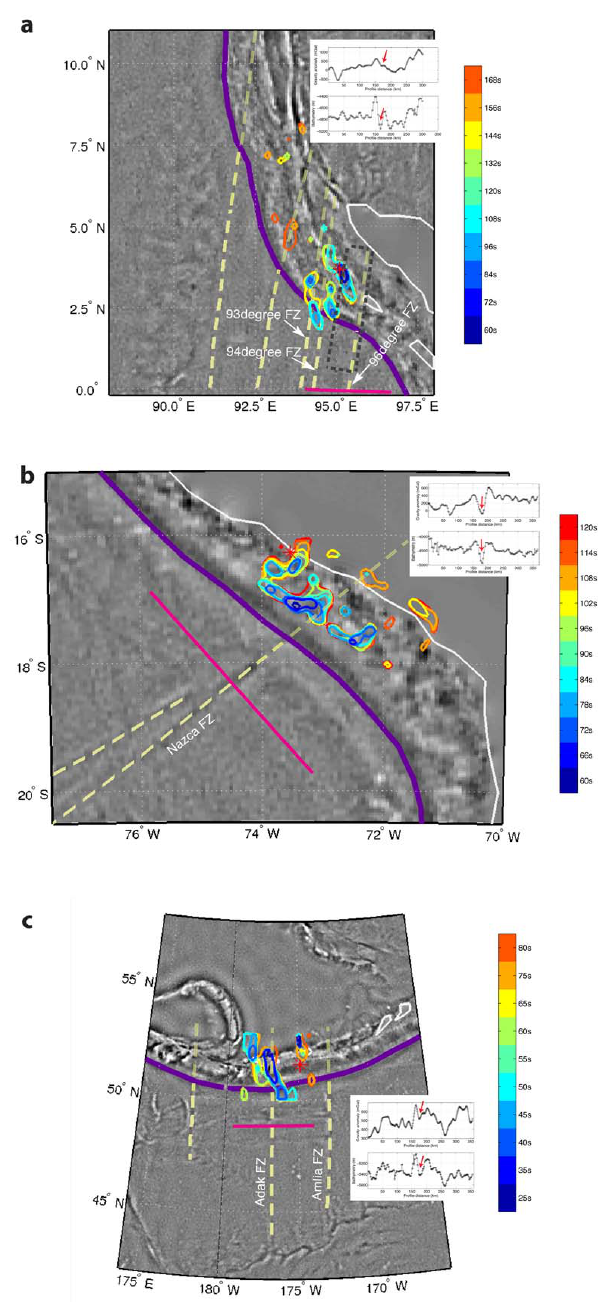
Fig. 4. Three great earthquake rupture case studies for (a) the 2004 M w =9.1 Sumatra-AndamanEarthquake(Robinson,2007)and (b) the2001 M w =8.4Peruearth- quake (Robinson, 2007) depicting the modelled rupture process through time for 5m slip contours, and (c) the 1986 M w =8.0 Andreanoff islands earthquake (Das and Kostrov, 1990) showing the modelled rupture process through time for a moment- magnitude contour of 3 × 10 20 Nm. Earthquake epicentres are shown as red stars, over- lain over vertical gravity gradient maps (Sandwell and Smith, 2009), with fracture zone locations (Matthews et al., 2011) shown as yellow dashed lines, with their interpreted coupling zone extensions outlined in faint yellow dashes. Coloured polygons illustrate the progression of the rupture process relative to the inception at the epicentre, pro- viding a visualisation of the role that the fracture zones played during the event. Inset plots show ship bathymetry (top) and gravity anomalies (bottom) along magenta pro- files crossing key fracture zones, with red arrows indicating fracture zone location. The seismicallyimagedSimeulueridge(Frankeetal.,2008),associatedwiththesubducting 96 ◦ Fracture Zone (Kopp et al., 2008), is outlined as black dashed